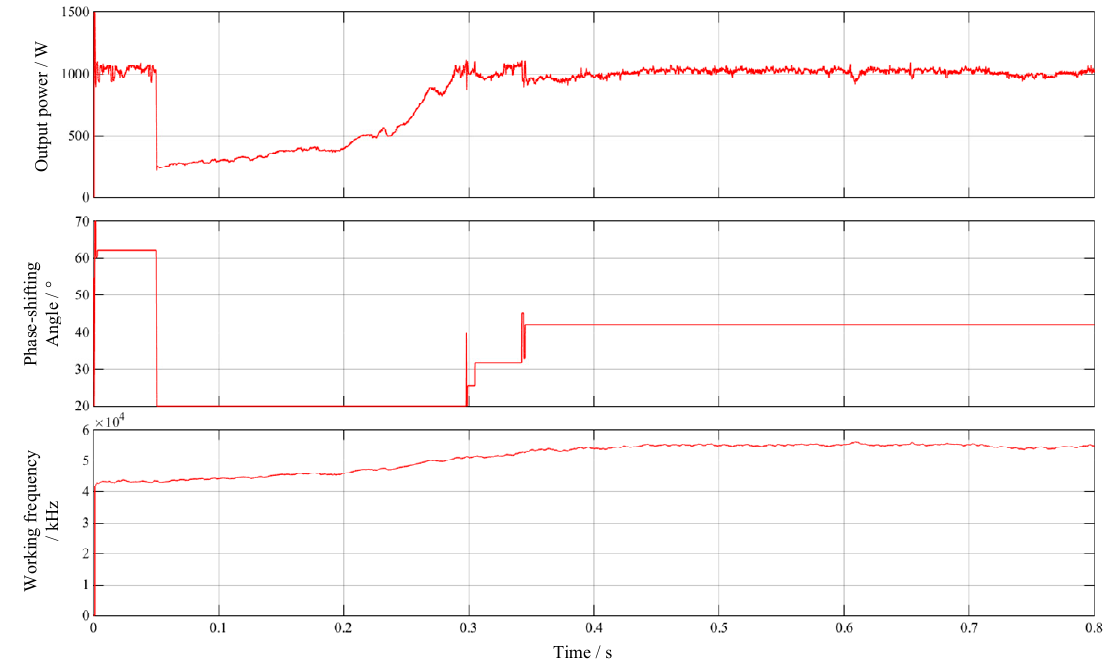
Figure 17. Anti-perturbation waveform when the load capacitance drops sharply.